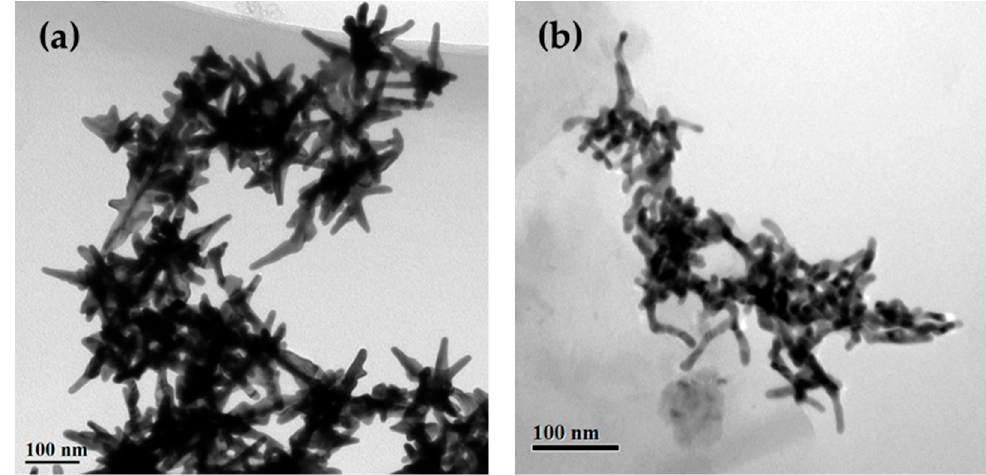
Figure 1. TEM images of AuCu nanocrystals with Au:Cu atom ratios of ( a ) 1.78 and ( b ) 0.33.